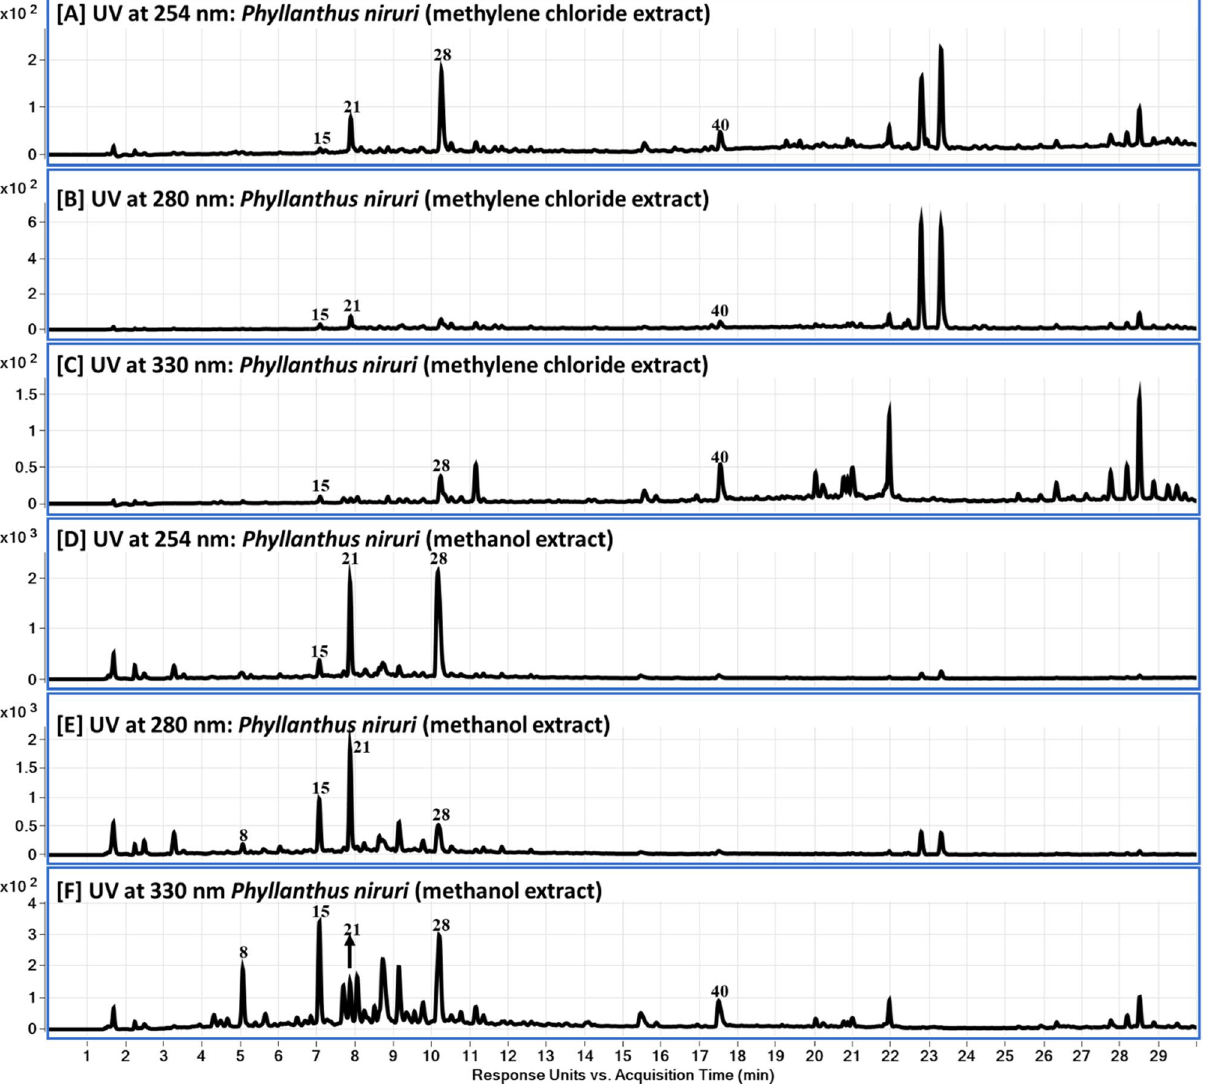
Figure 2. LC-DAD chromatograms of the CH 2 Cl 2 fraction ( A – C ) and MeOH extract ( D – F ) of P. niruri. at 254, 280 and 330